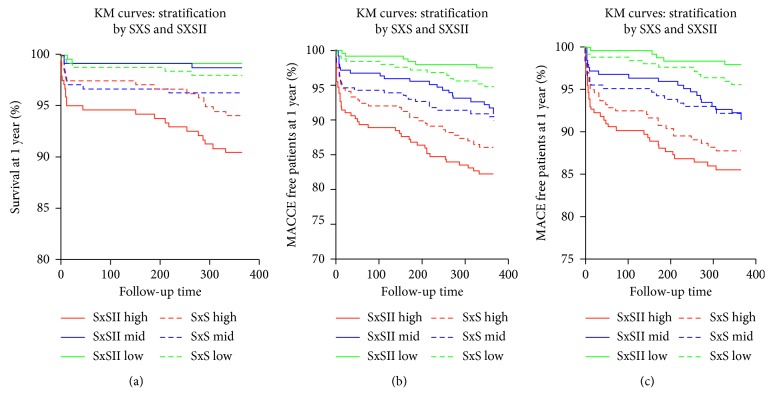
Kaplan–Meier survival curves at 1-year follow-up for freedom from all-cause mortality, MACCE, and MACE.